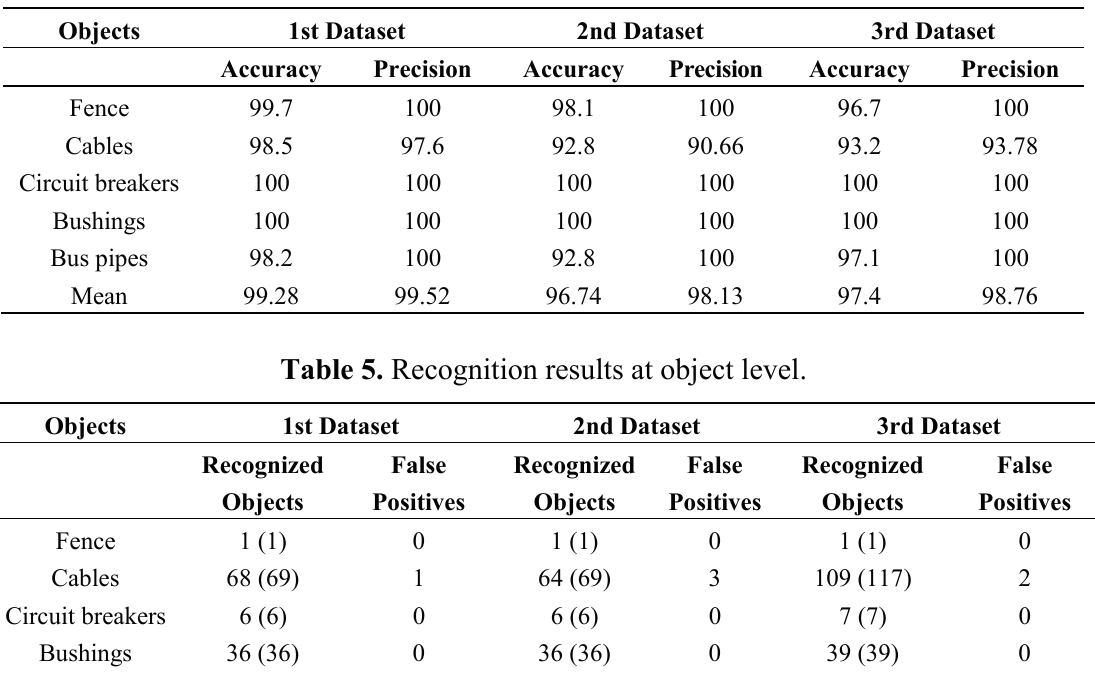
Table 4. Accuracy and precision of object recognition at point cloud level (in percentage).